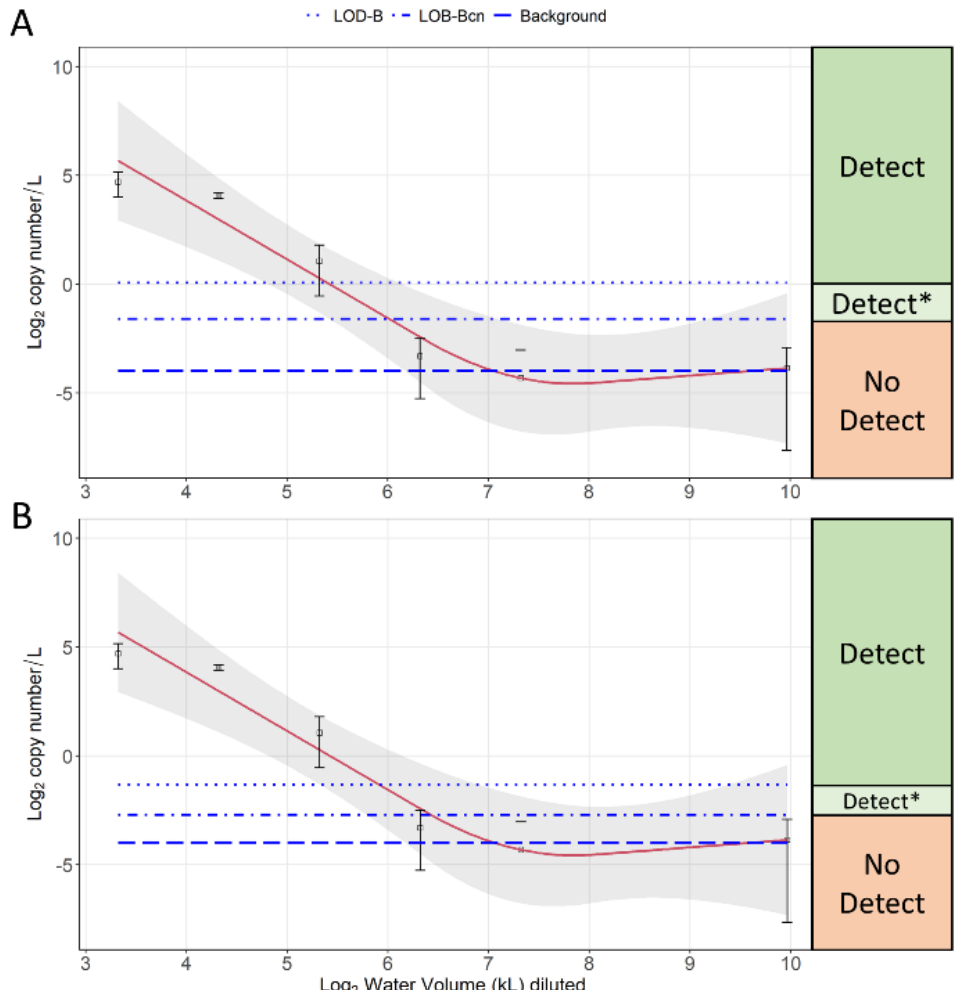
Figure 4. Illustration of the impact of technical replicate number of either ( A ) eight or ( B ) 24 on the interpretation of “Detect” and “No Detect” in the context of the dilution experiment results from 10 kL tanks at the Goldstream hatchery showing predicted copy number (log 2 copies per L) for the coho salmon assay eONKI4 versus volume of water diluted (log 2 kL). The bent cable model curve (red line) is shown with the estimated 95% confidence interval shaded in grey and the estimated background copy number/L (“Background”) indicated by the horizontal blue long dashed line. The background-corrected LOD and LOB (LOD-B and LOB-B cn , respectively) were calculated for eight or 24 technical replicates. The log 2 LOD-B is shown as a blue dotted horizontal line. The log 2 LOB-B cn (blue dot-dashed horizontal line) is the LOB-B converted to copy number/L. The rectangles to the right of the graphs indicate the detection interpretation zones. Detect* refers to possible detection but requires more data to determine.